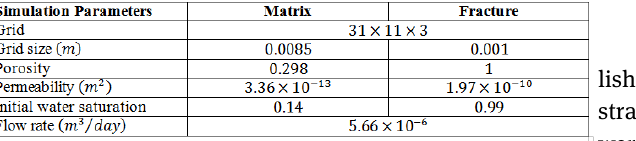
Model results were compared with validated and